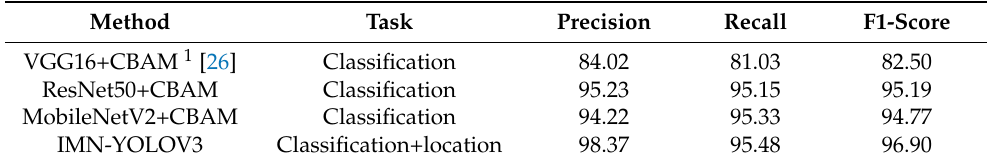
Table 5. Classification results on